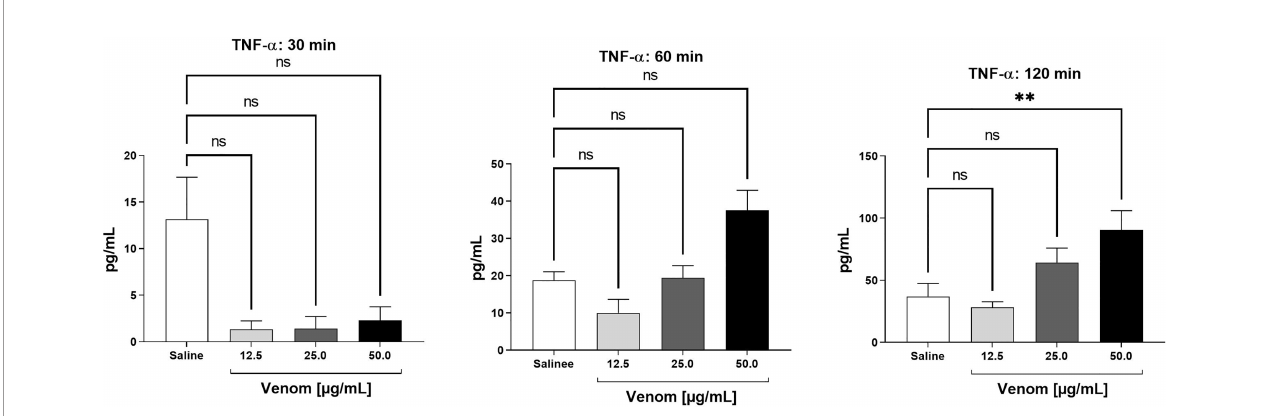
FIGURE 3 | TNF- a levels in human plasma after treatment with B. jararaca venom. Human blood samples containing GPRP (8 mg/mL) were incubated with increasing concentrations of B. jararaca venom or sterile saline solution for 30, 60 and 120 minutes at 37°C. After plasma collection and dilution (1:2), the presence of TNF- a was evaluated by cytometric bead array (CBA). The results are represented as the mean ± SEM of duplicates from three independent tests. ns, not signi fi cant; ** p ≤ 0.005.